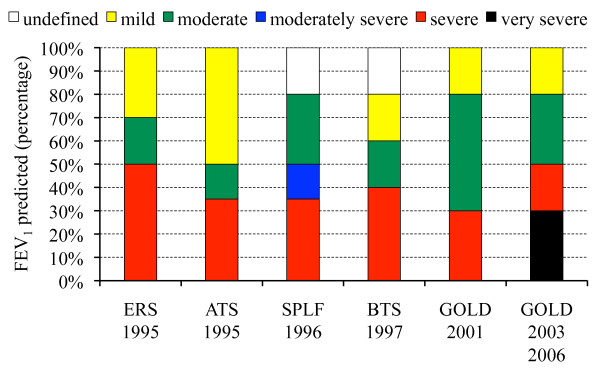
The most popular chronic obstructive pulmonary disease classifications: ERS, European Respiratory Society; ATS, American Thoracic Society; SPLF, Société de Pneumologie de Langue Française; BTS, British Thoracic Society; GOLD, Global Initiative for Chronic Obstructive Lung Disease; FEV1, forced expiratory volume in 1 second. ATS, BTS, ERS and SPLF classifications define three stages of severity between 0% and 100% (ATS and ERS) or 80% (BTS and SPLF) of predicted FEV1. The most recent classification is the GOLD classification, which was initially proposed in 2001 and has been modified twice, in 2003 and 2006. In 2003, the GOLD classification evolved from three to four stages plus a supplementary stage 0 defining patients at risk (that is, the presence of chronic cough and sputum, but no obstruction together with FEV1 over forced vital capacity ratio >70%; stage 0 is not shown in the figure), and stage 0 was not kept in the GOLD classification system in 2006.